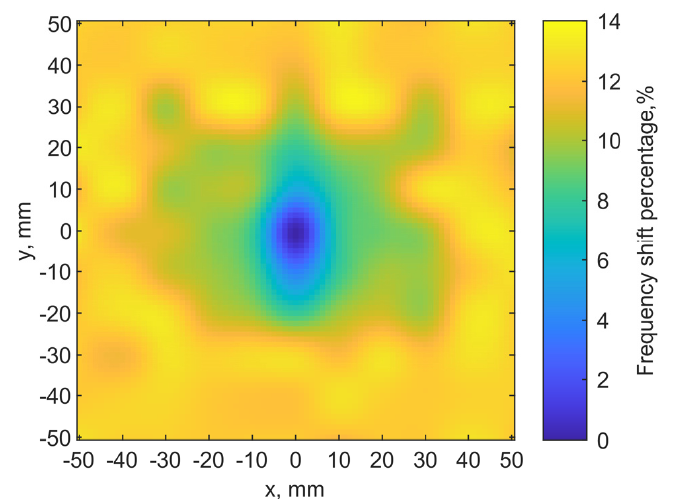
Figure 17. Rendering results using the cubic spline interpolation from measurement data at depths of 6